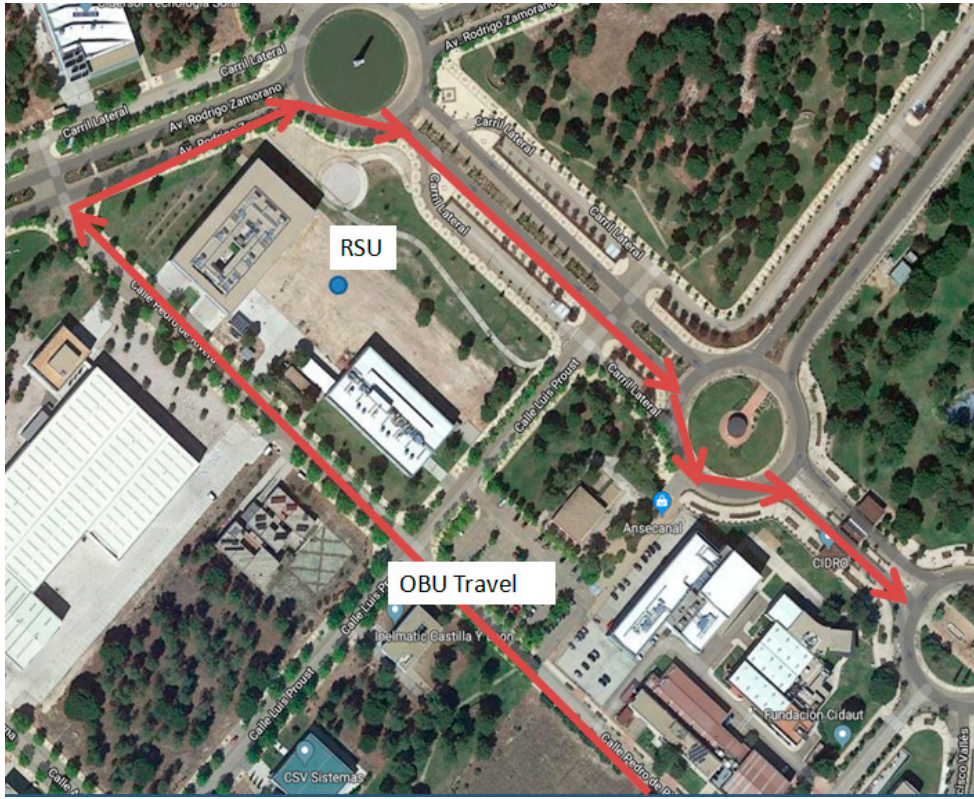
Figure 8. Experimental design in Boecillo .